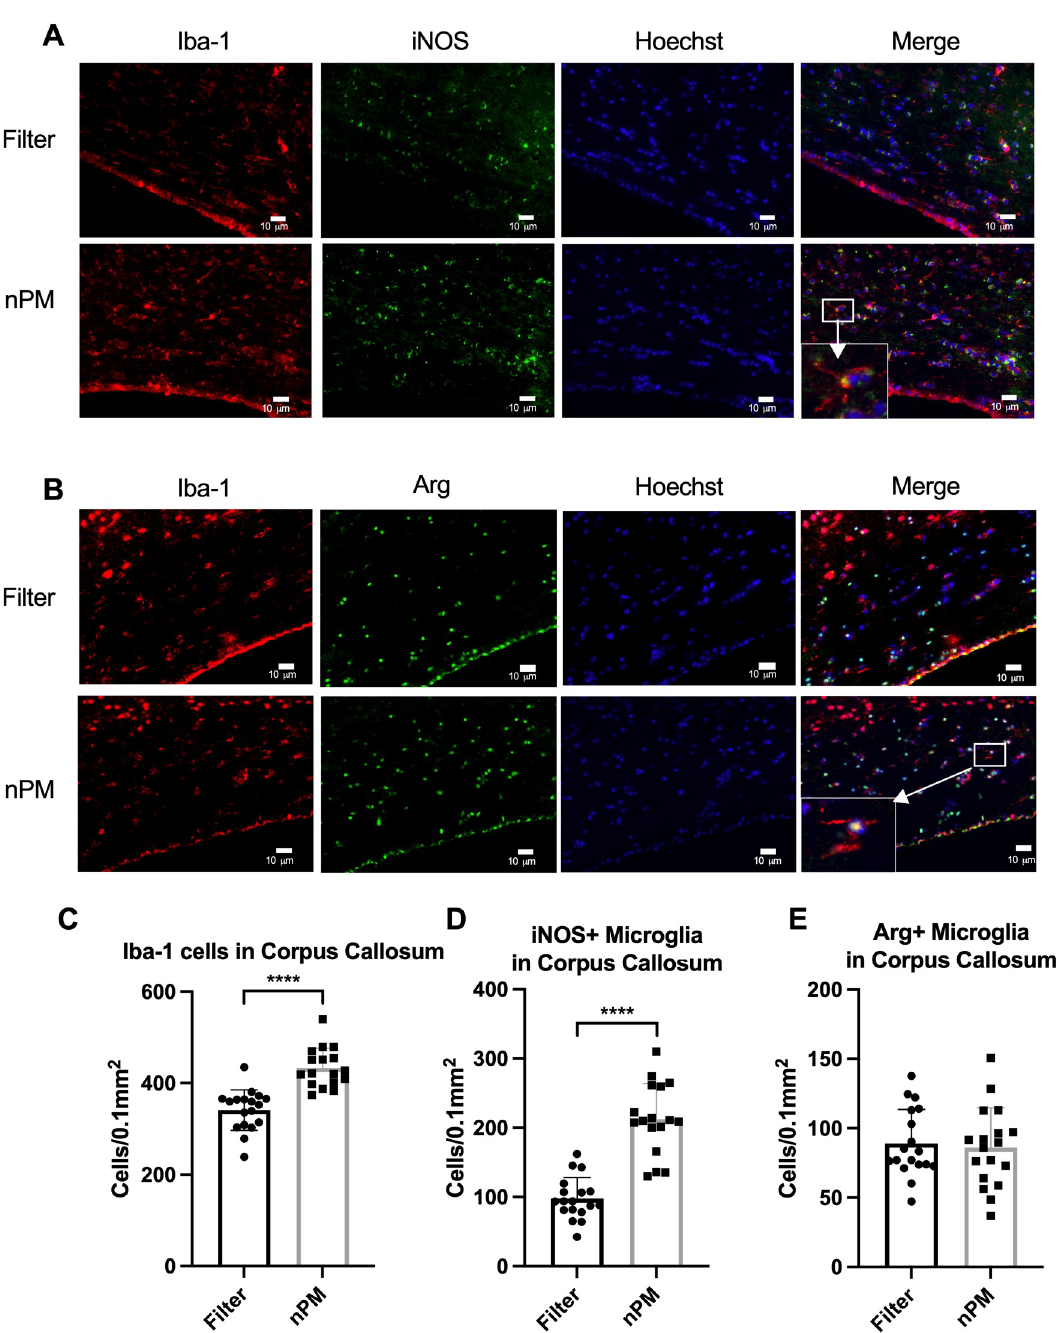
Fig 1. nPM exposure results in an inflammatory microglia response in the corpus callosum. (A) Iba-1+iNOS microglia in the corpus callosum of mice exposed to filtered air and nPM, with representative image of a positive cell at high magnification. (B) Iba-1 +Arg microglia in the corpus callosum of mice exposed to filtered air and nPM, with representative image of a positive cell at high magnification. (C) Iba-1 positive microglia cell counts were significantly increased in the corpus callosum of mice exposed to nPM (n = 17) compared to filtered air (n = 18) (p < 0.0001). (D) iNOS positive microglia cell counts were significantly increased in the corpus callosum of mice exposed to nPM (n = 17) compared to filtered air (n = 18) (p < 0.0001). (E) Arginase-1 positive microglia cell counts were not significantly different in the corpus callosum of mice exposed to nPM (n = 18) compared to filtered air (n = 18) (p = NS). Data presented as mean ± standard deviation. Scale bars represent 10 μ m. Error bars represent standard deviation. ���� signifies p <